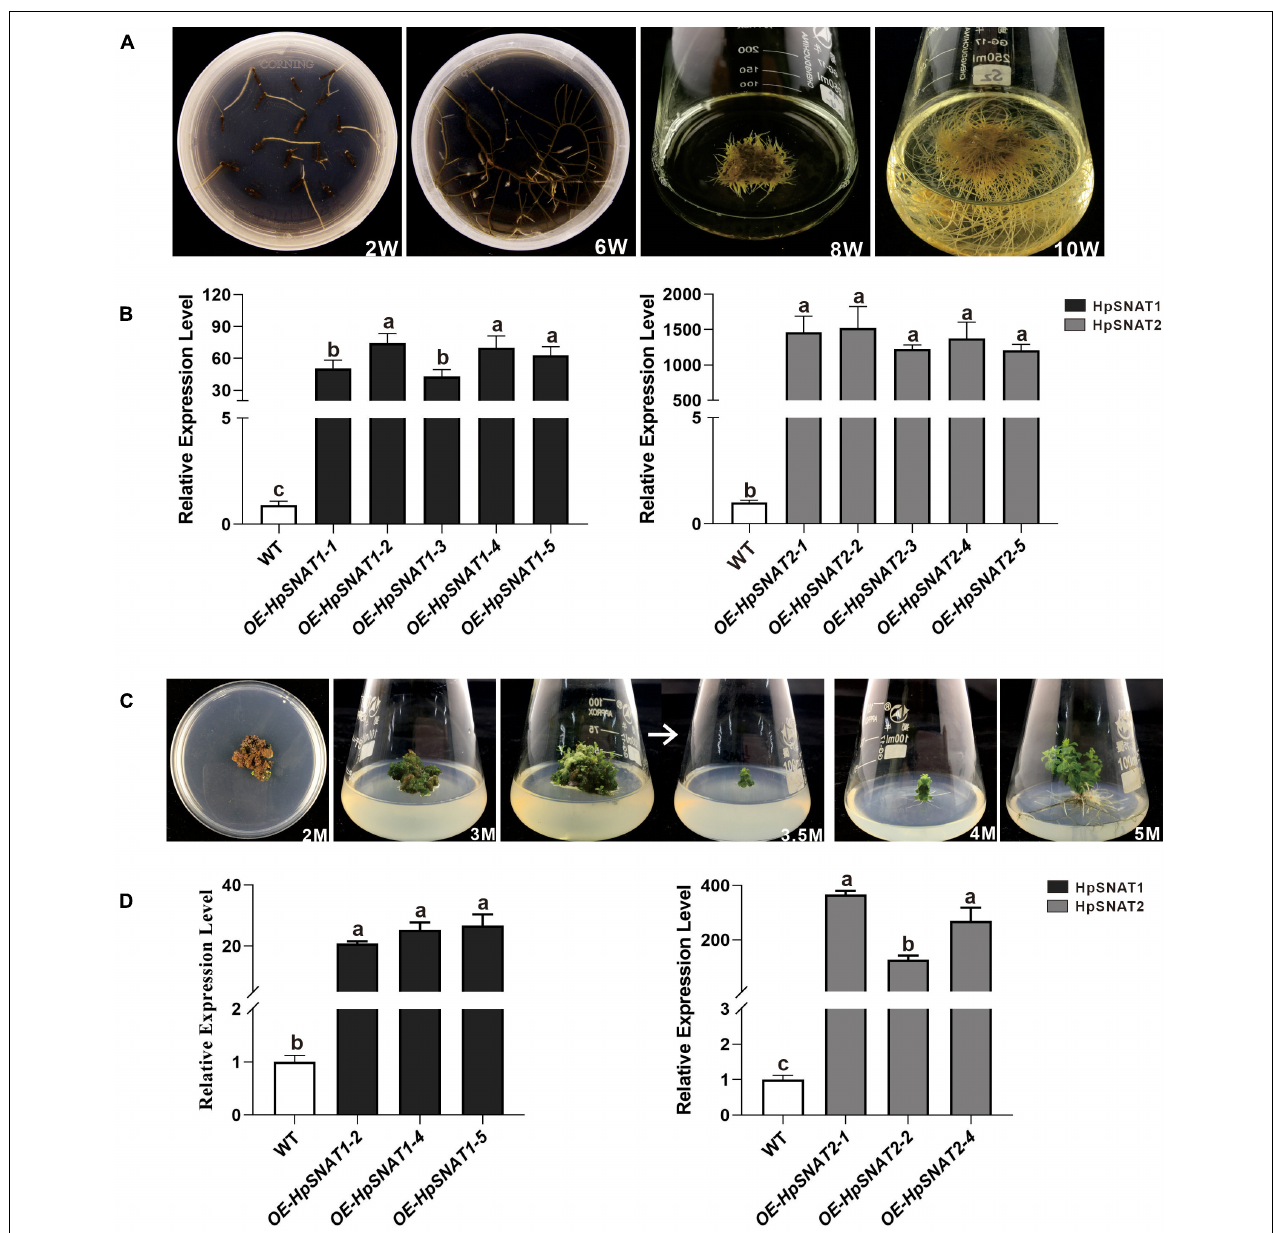
FIGURE 5 | Selection of positive hairy roots (HRs) lines and generation of adult transgenic H. perforatum . (A) The phenotypes of HRs induction at different time (W: week). (B) Relative quantitative analysis of HpSNAT1 and HpSNAT2 expression in overexpression (OE) and control of H. perforatum HRs (WT: the line infected by A . rhizogenes , K599 only). Data were normalized by HpACT2 (MK054303), calculated with the equation 2 −(cid:52)(cid:52) Ct . All data represent averages of three biological replicates, error bars indicate ± SD. (C) Plant regeneration from H. perforatum HR cultures (M: month). (D) Relative quantitative analysis of HpSNAT1 and HpSNAT2 expression in OE and control of H. perforatum plants. Data were normalized by HpACT2 (MK054303), calculated with the equation 2 −(cid:52)(cid:52) Ct . All data represent averages of three biological replicates, error bars indicate ±